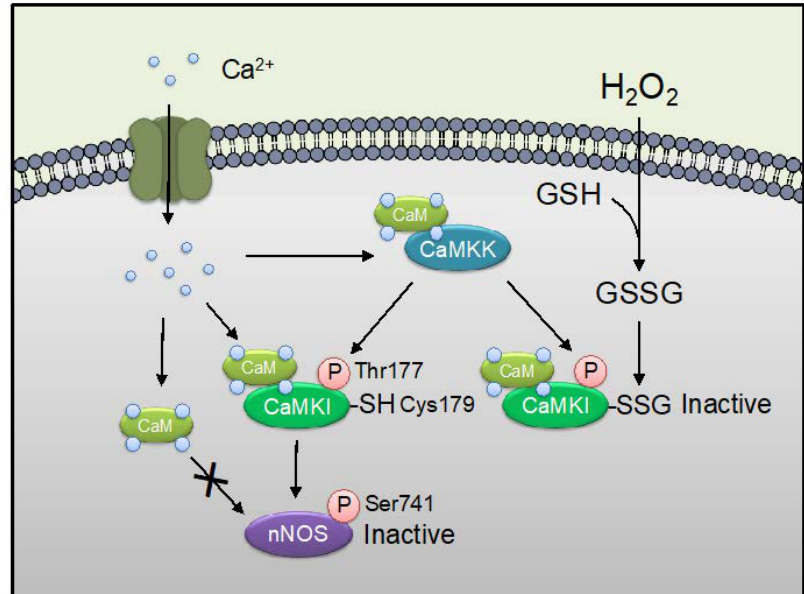
Figure 4. The S -glutathionylation of CaMKI modulates nNOS enzyme activity. Ca 2 + influx activates CaMKK, CaMKI, and nNOS. CaMKI is activated by Ca 2 + / CaM binding and phosphorylation at Thr177 by upstream CaMKK. Activated CaMKI phosphorylates at Ser741 of nNOS in the CaM binding region, as a result, CaM is not to be able to bind to nNOS. H 2 O 2 stimuli indices S -glutathionylation at Cys179 nearby Thr177 phosphorylation site of CaMKI. Note that S -glutathionylation of CaMKI at Cys179 appeared to be dominant over activation of the kinase by phosphorylation at Thr177 [53,83]. Thus, the illustration means ROS signaling mediates NO signaling via S -glutathionylation of